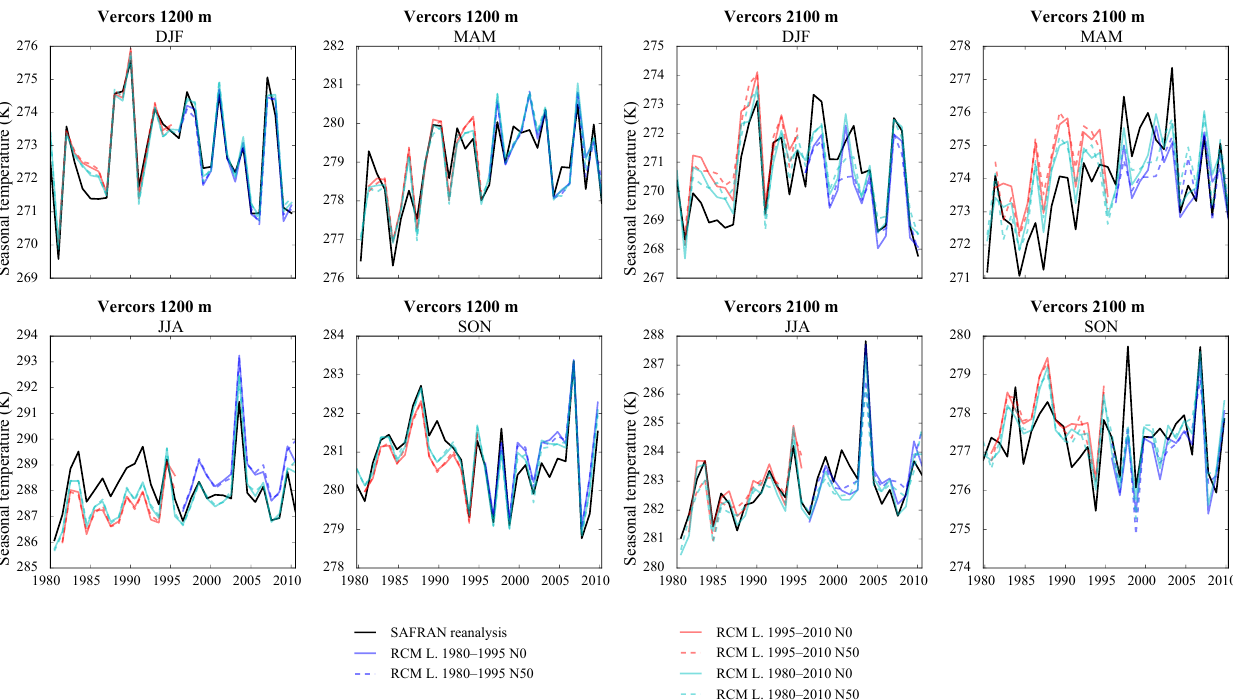
Figure 12. Seasonal average time series of temperature from 1980 to 2010 in each adjusted RCM simulation and in the SAFRAN reanalysis for the Vercors massif at 1200 and 2100ma . s . l .